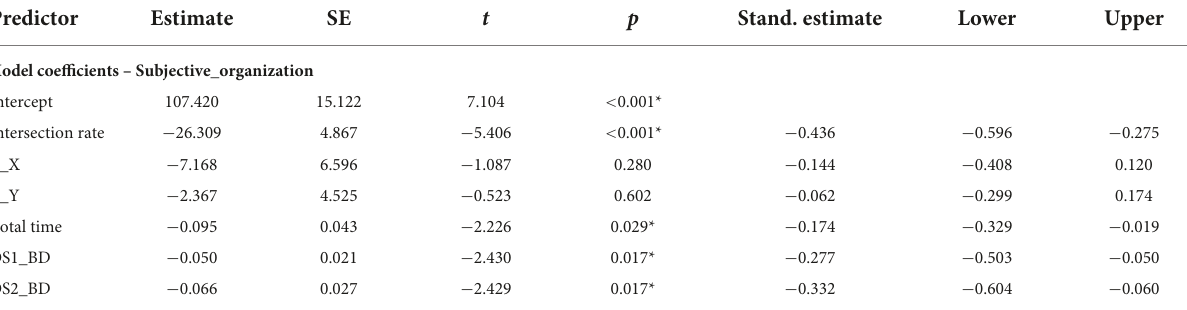
TABLE 4 Multiple regression analysis of the indexes on the subjective evaluation of the organization.